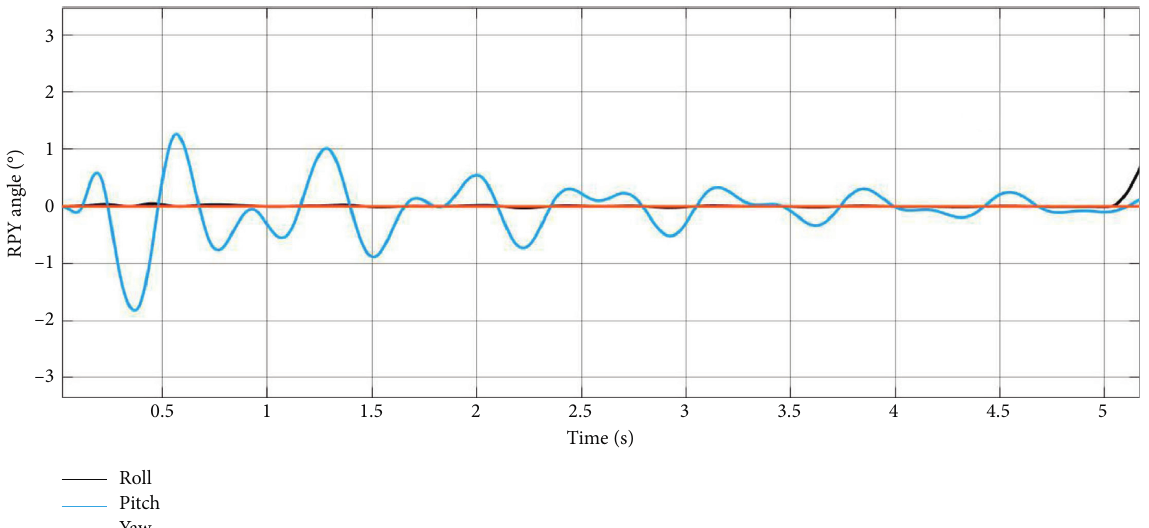
Figure 12: RPY output response curve of compound controller between 0 and 5